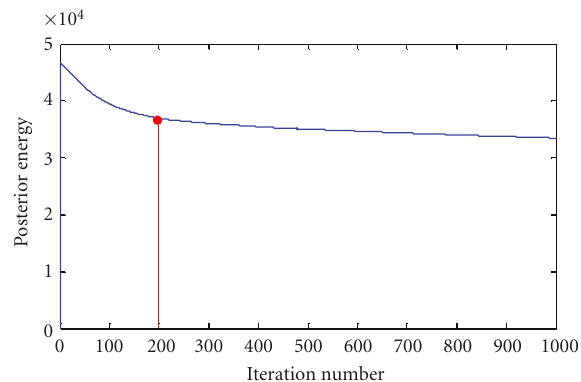
Figure 5: Using the proposed restoration algorithm in Section 3, the calculated posterior function energy with respect to iteration number is